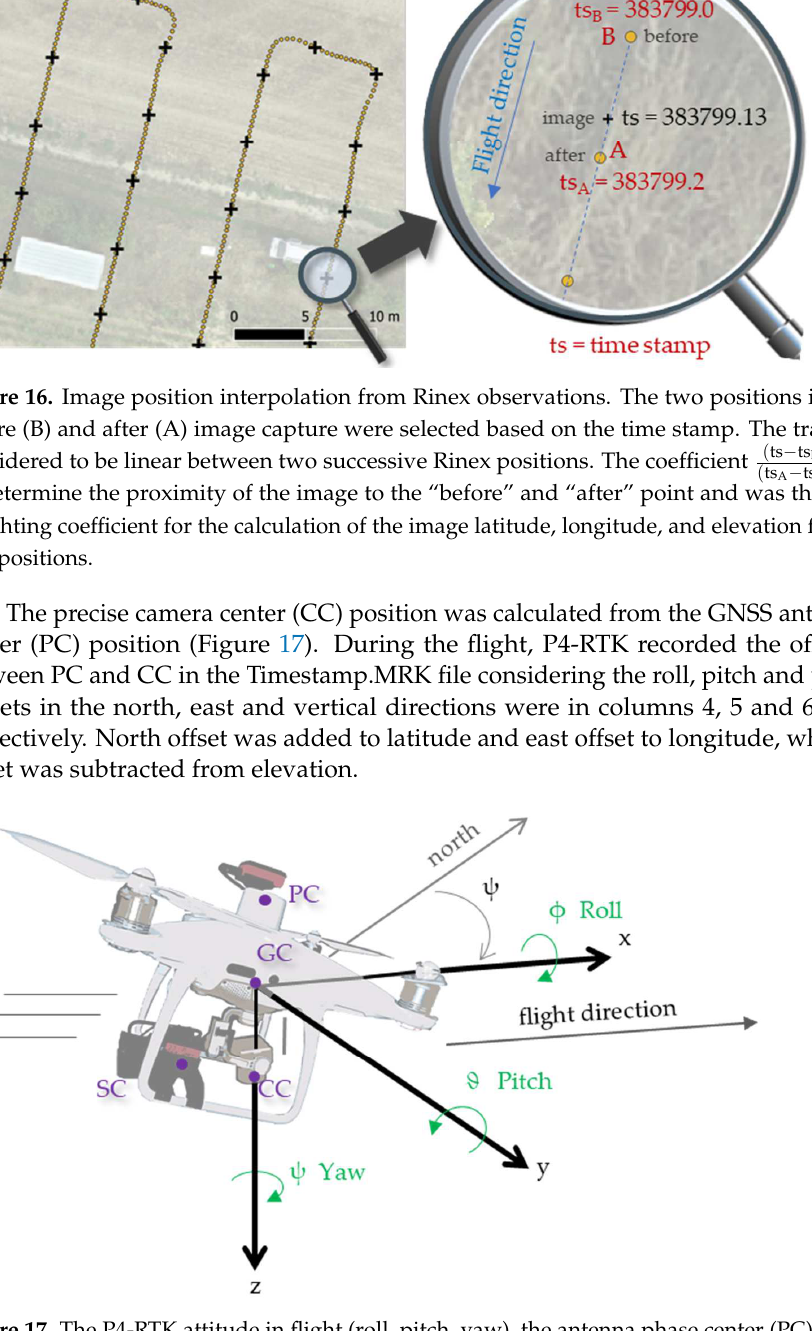
Figure 17. The P4-RTK attitude in flight (roll, pitch, yaw), the antenna phase center (PC), the P4-RTK gravity center (GC) and the SEQUOIA camera center (SC).